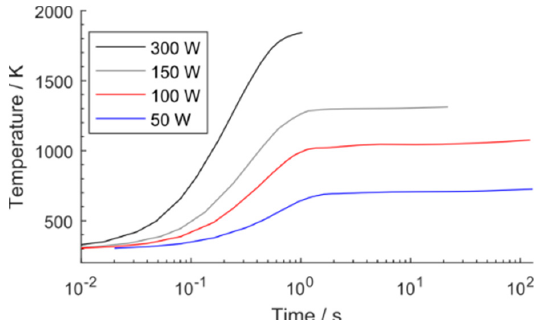
Figure 1. Simulated mean temperature on the surface of the SiC samples as a function of irradiation time and laser power.